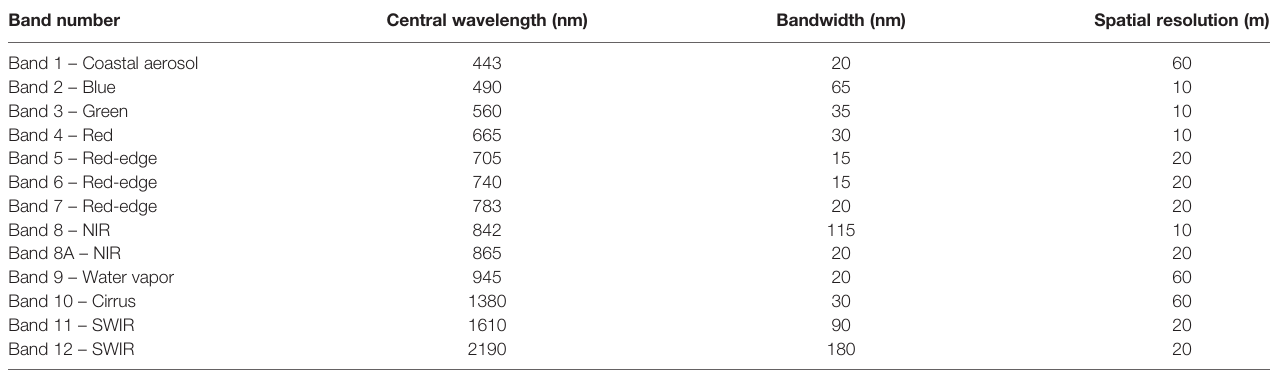
TABLE 2 | Spectral bands for Sentinel-2 sensors (Drusch et al., 2012). Bands 8, 9 and 10 were eliminated in this study due to the wavelength overlap or absence of water surface information. Band number Central wavelength (nm) Band 1 – Coastal